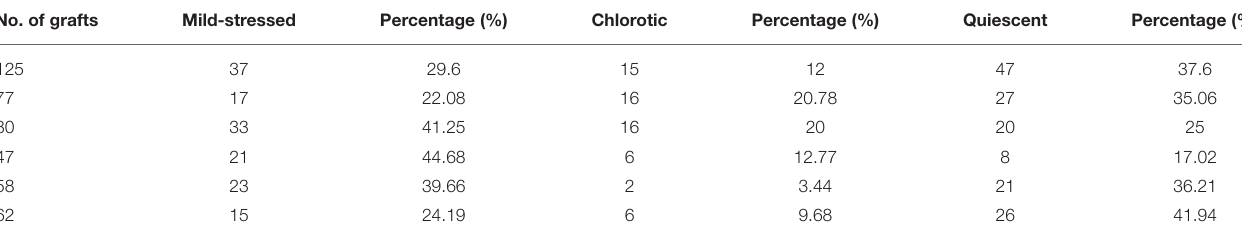
TABLE 1 | Three types of At / Nb grafts at 30 DAG: mild-stress grafts, chlorotic grafts, and quiescent grafts. No. of